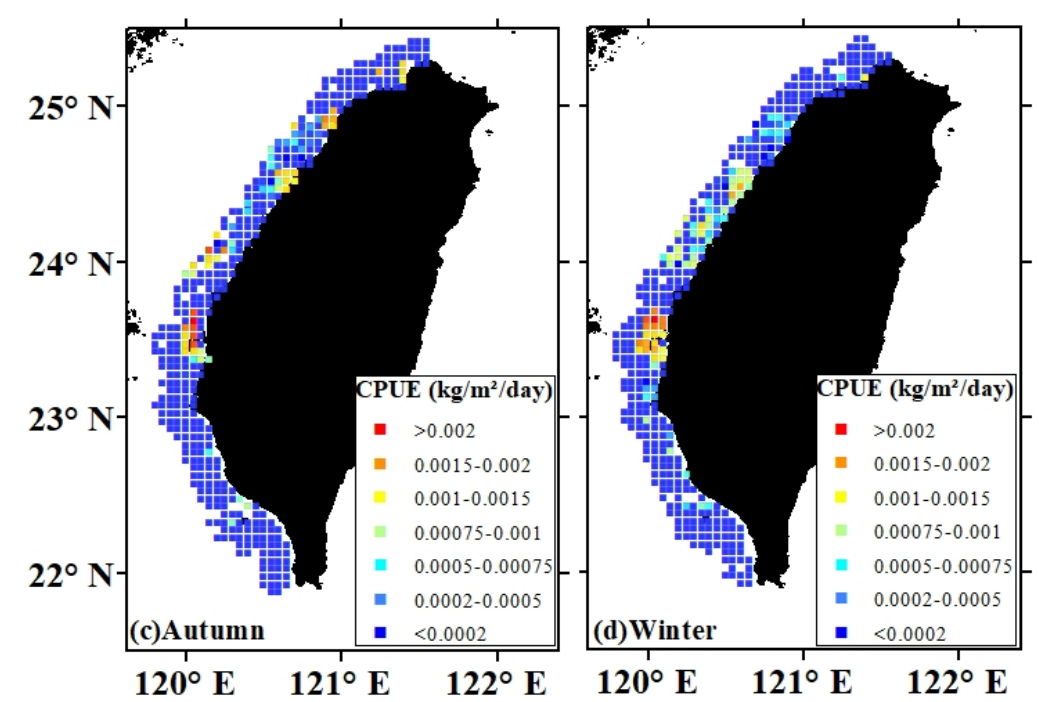
Figure 3. Catch per unit effort, CPUE (kg/m 2 ) distributions of black sea bream from sampled gillnet vessels by season in waters off western Taiwan.